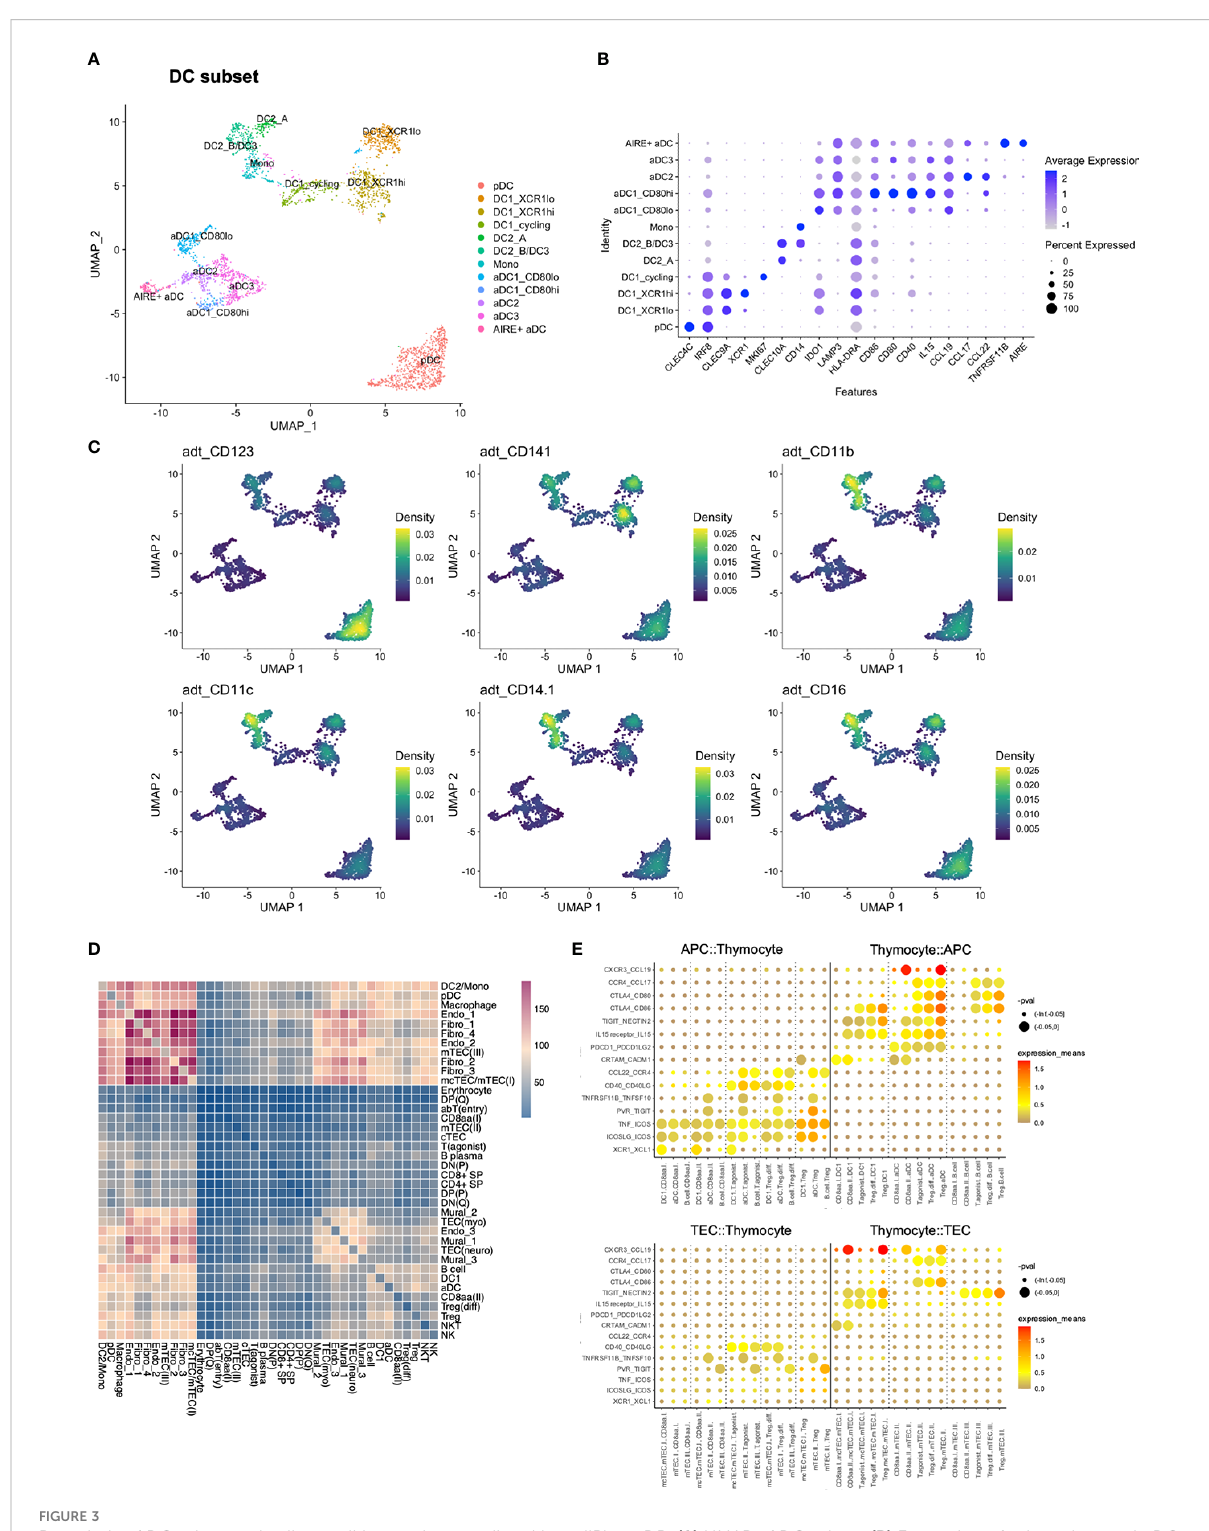
FIGURE 3 Reanalysis of DC subset and cell-to-cell interactions predicted by cellPhoneDB. (A) UMAP of DC subset. (B) Expression of selected genes in DC subset. (C) Density plot created by Nebulosa showing expression of selected proteins in the DC subset, adt = antibody derived tag. (D) Heatmap showing the number of predicted interactions between each combination of annotated cell types/states. (E) Expression of selected ligand- receptor pairs in selected pairs of cell types/states. Colour represents the mean of the average expression level of molecule 1 in cell type/state 1, and molecule 2 in cell type/state